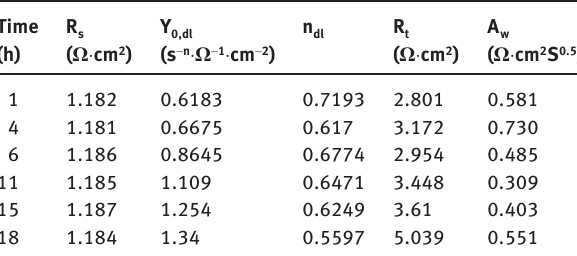
Table 4: Fitting results of electrochemical impedance spectra for the corrosion of pure Cr in molten (Li,Na,K)F at 973 K